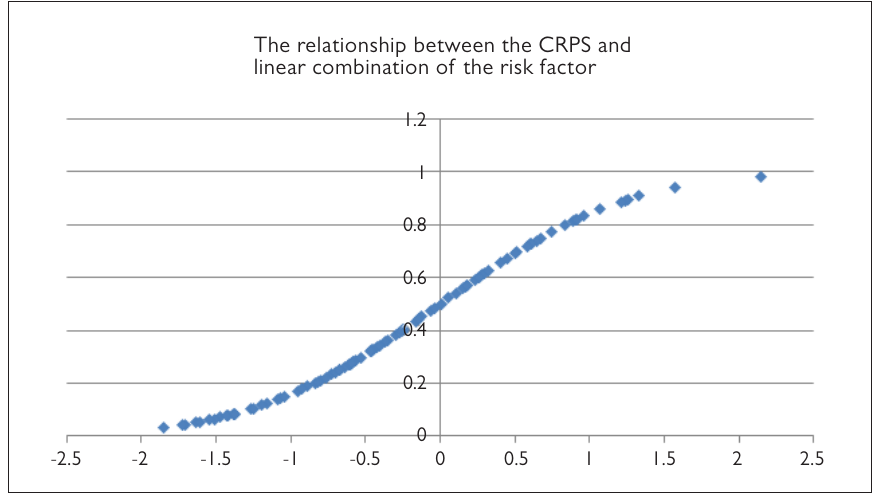
Figure 3. Fracture regions and CRPS regions of patients with CRPS-1